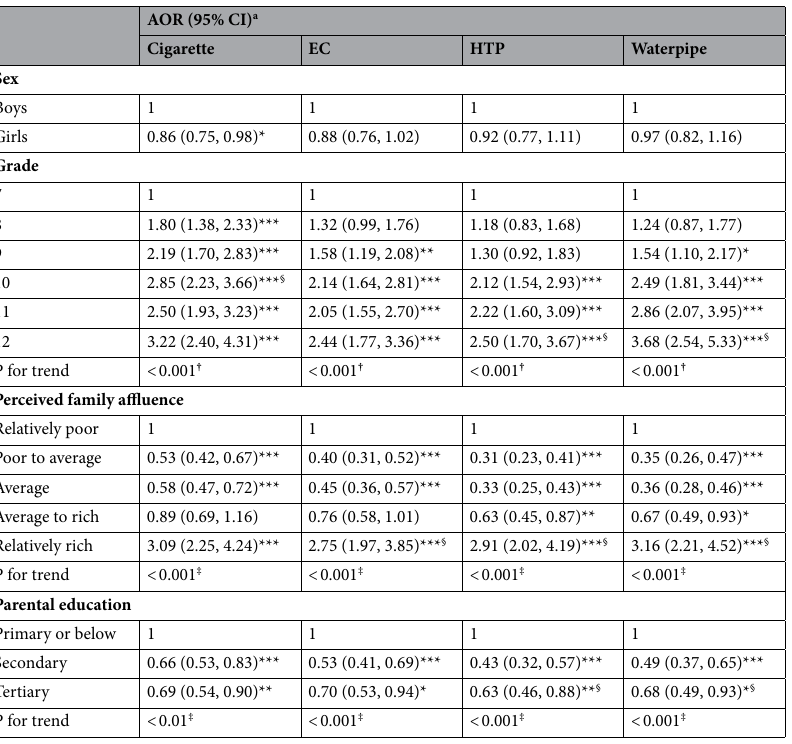
Table 3. Associations between sociodemographic factors and current (vs non-current) tobacco use in Hong Kong secondary school students. * P < 0.05, ** P < 0.01, *** P < 0.001. † Linear trend. ‡ Curvilinear (quadratic) trend. § Interaction with sex. EC, e-cigarette; HTP, heated tobacco product; AOR, adjusted odds ratio; CI, confidence interval. a Adjusted odds ratios adjusted for sex, grade, perceived family affluence, parental education, and school clustering